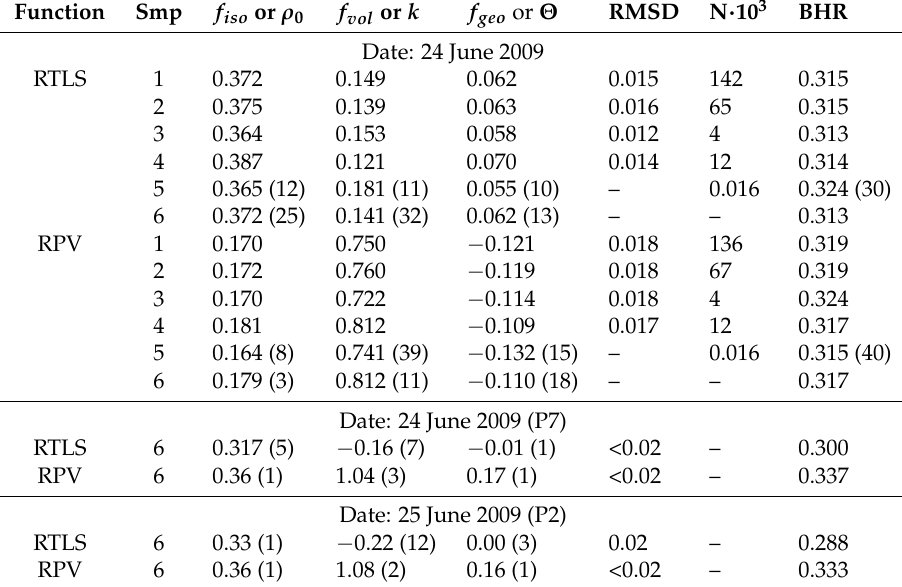
Table 3. Bi-directional reflectance factor (BRF) parameter retrieval for the green band (551 nm) for Ross Thick-LiSparse (RLTS) and Rahman–Pinty–Verstraete (RPV) functions using different subsetting of the RRV PARABOLA datasets, as described in the text. The uncertainty reported for sampling methods ( 5-6 ) associated with the median value, represents half the interquartile range (IRQ/2). The last column values (BHR) are obtained by integrating the bi-directional reflectance distribution functions (BRDF) functions with the inverted parameters. Sampling methods (Smp) are 1. full , 2. balanced , 3. pp , 4. θ v ∼ 45 ◦ , 5. random and 6. set-by-set for the 24 June 2009. For the 2014 dataset only the set-by-set inversion statistics are